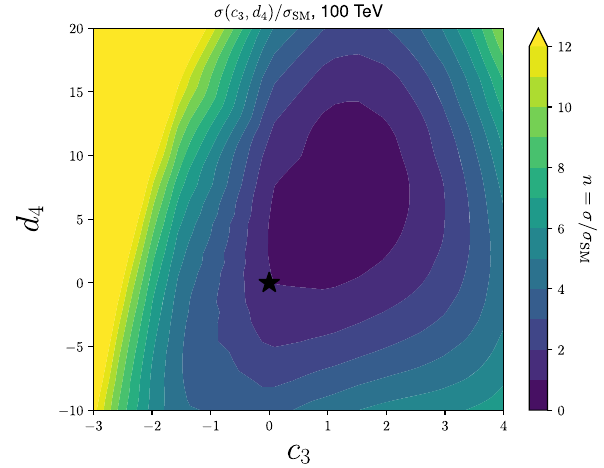
Fig. 3 Example Feynman diagrams contributing to Higgs boson triple production via gluon fusion in the Standard Model, taken from [19]. The vertices highlighted with blobs indicate either triple (blue) or quar- tic (red) self-coupling contributions. In the ( c 3 , d 4 ) model, a produces